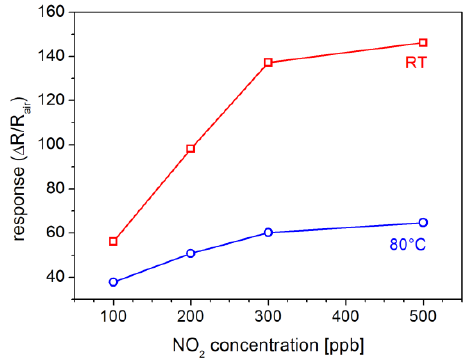
Figure 8. Response of a ZnO-TPs+TiOPc sensor towards different concentrations of NO at room temperature (RT) and 80 °C (RH